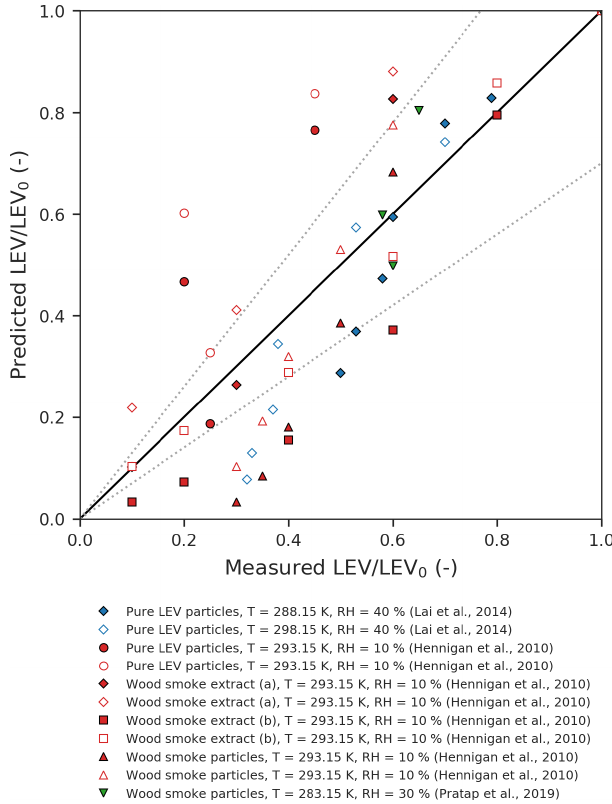
Figure 2. Parity plot of the predicted vs. measured LEV concen- tration (normalized by the initial concentration). The dotted lines represent the ± 30% error